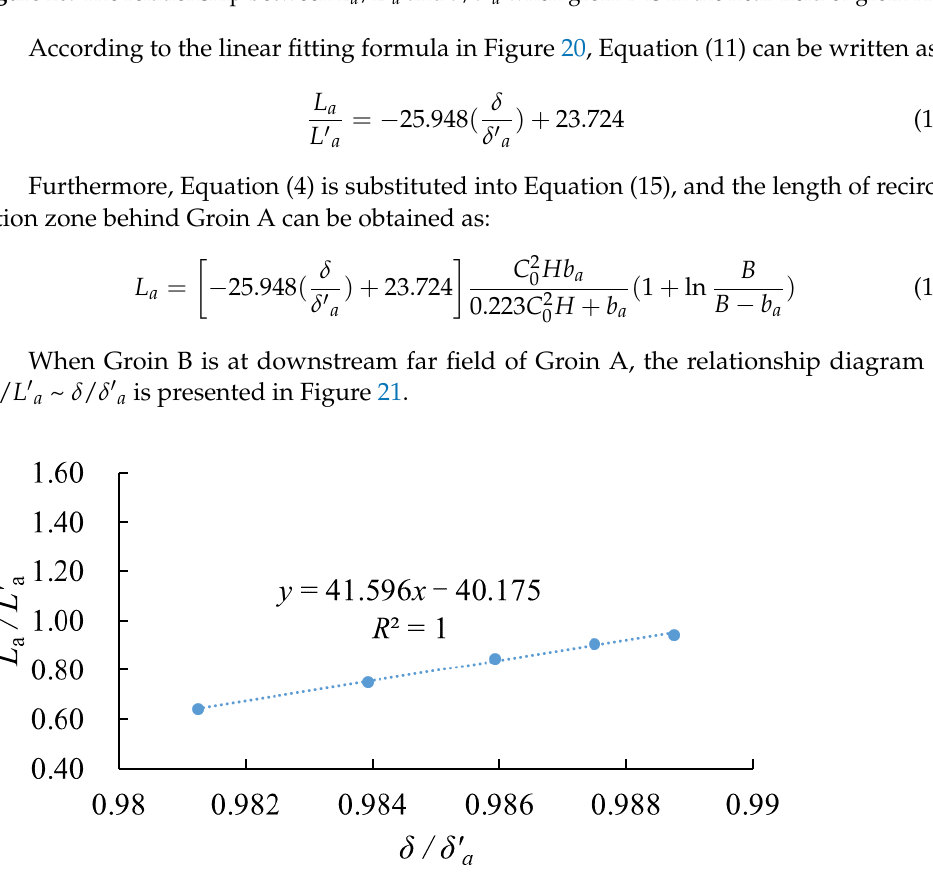
Figure 21. The relationship between L a / L’ a and δ / δ’ a when groin B is in the downstream far-field of groin A.